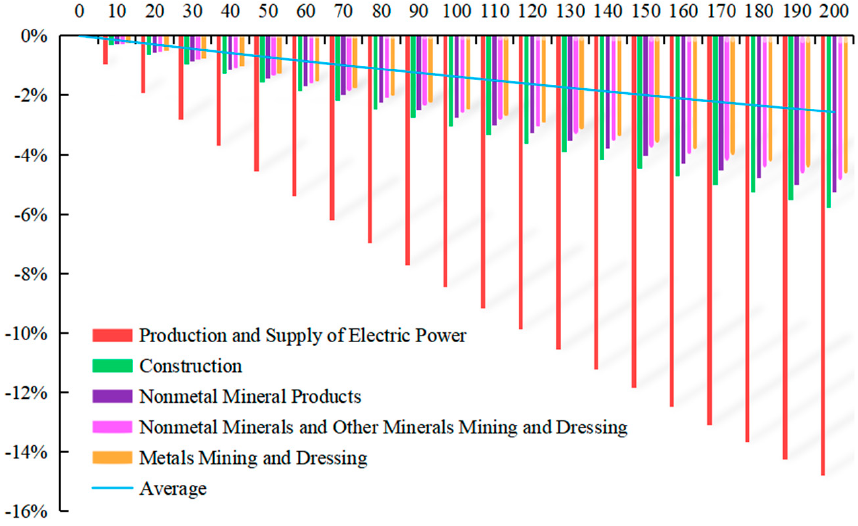
Figure 3. Relationship between carbon tax and sectoral GDP.